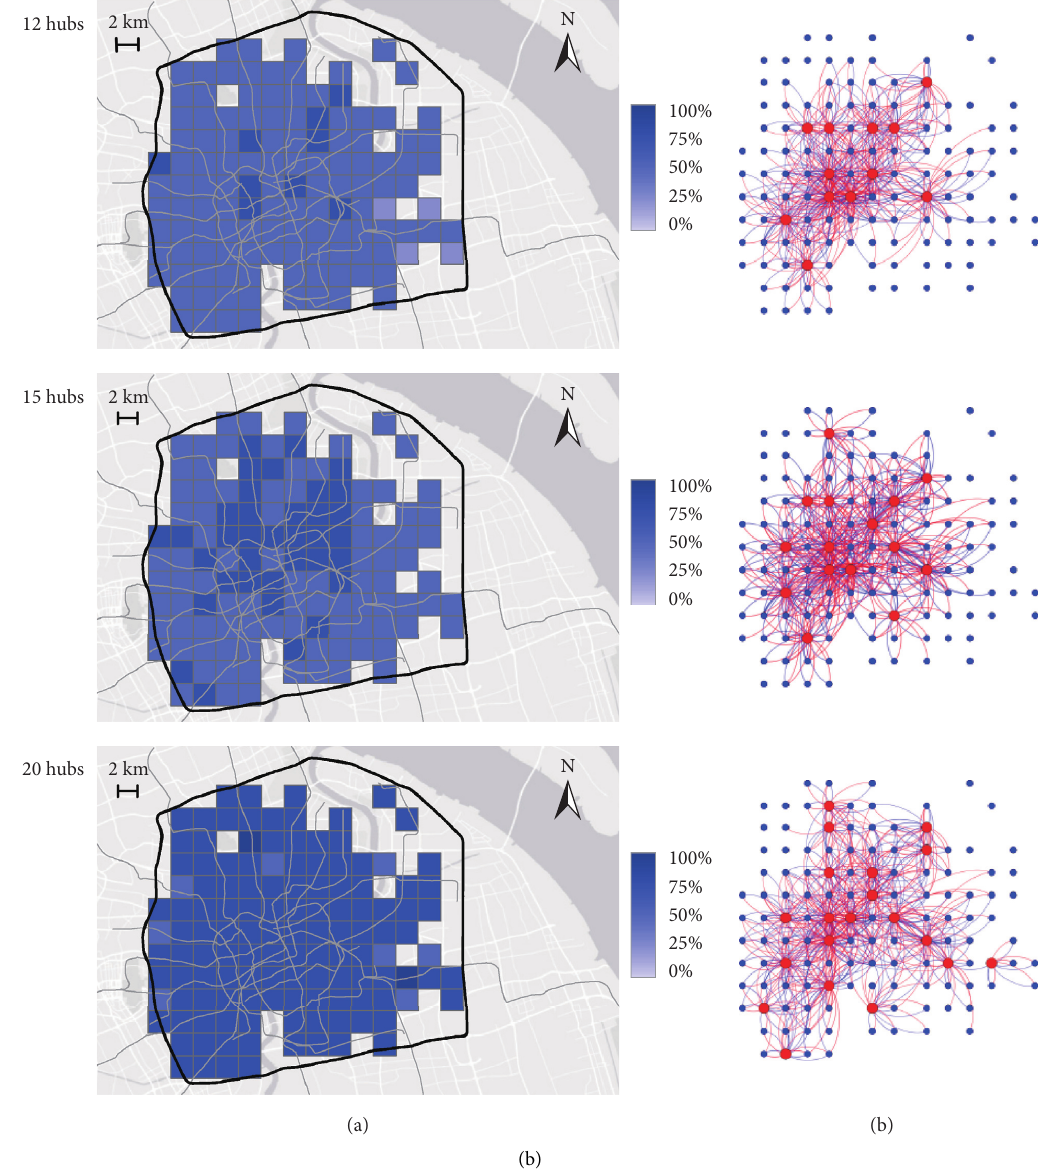
Figure 6: Proportion of package demand transported by taxi in each zone (a) and the spatial distribution of hubs